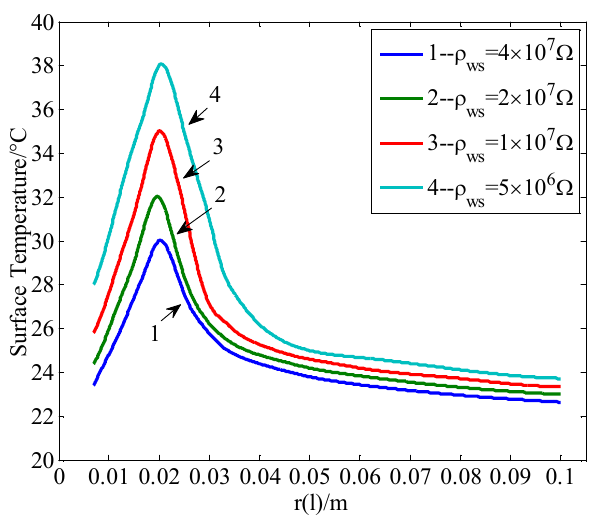
Figure 5. Numerical simulation of temperature distribution on the insulator surface.